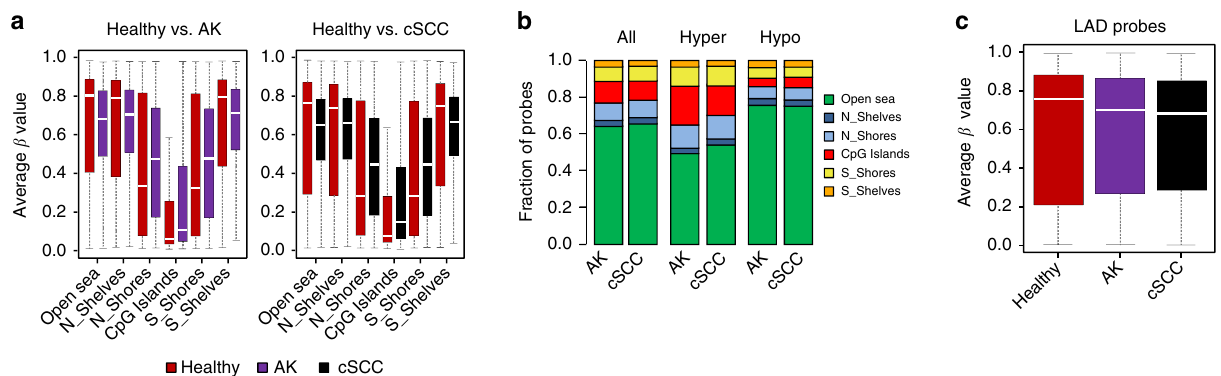
Fig. 2 AK and cSCC methylomes show cancer-speci fi c features. a Methylation status of the different epigenomic substructures in the epidermis of AK (left) and cSCC (right) patients compared to healthy controls. The box plots indicate highly signi fi cant ( P ≤ 9.1E − 77, two-sided t -test) hypermethylation of the CpG islands and hypomethylation of the Open Sea probes in both AK and cSCC samples. b Fractions of hyper and hypomethylated CpGs in AK and cSCC epidermis, within different epigenomic substructures and in comparison to healthy skin. c Probes within lamina-associated domains (LADs) are